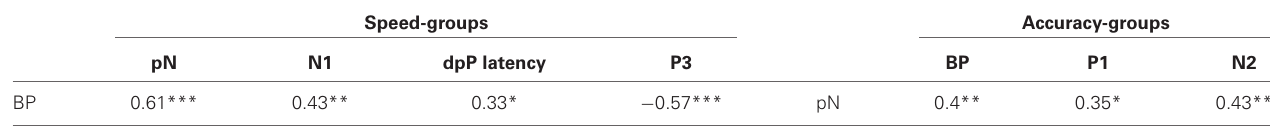
Table 2 | Correlations ( r -values) between ERP components in the Speed- and Accuracy-groups .